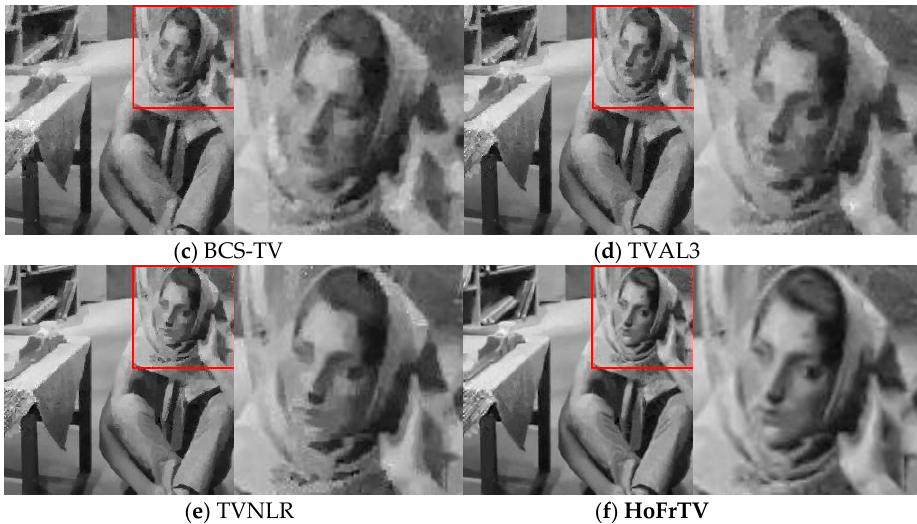
Figure 7. Reconstructed images (barbara) for measurement rate = 0.2 ( a ) PSNR = 28.103 dB and SSIM = 0.815; ( b ) PSNR = 27.748 dB and SSIM = 0.847; ( c ) PSNR = 26.585 dB and SSIM = 0.778; ( d ) PSNR = 26.812 dB and SSIM = 0.788; ( e ) PSNR = 27.237 dB and SSIM = 0.808; and (f) PSNR = 28.304 dB and SSIM = 0.834.